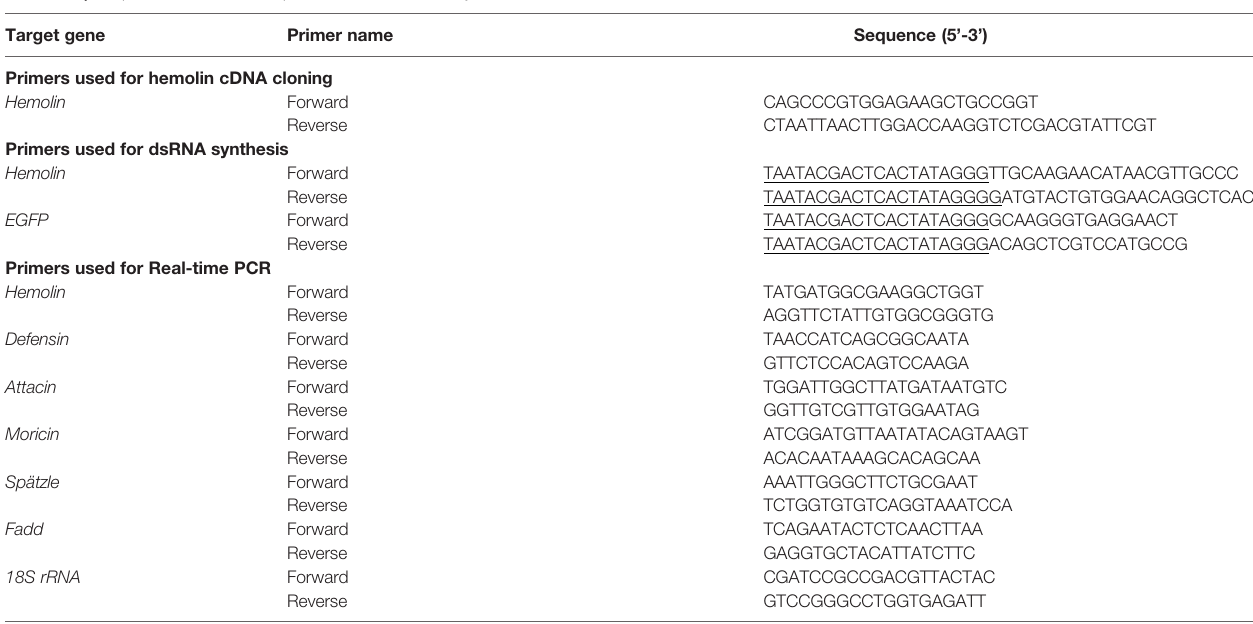
TABLE 1 | Sequence information of primers used in the